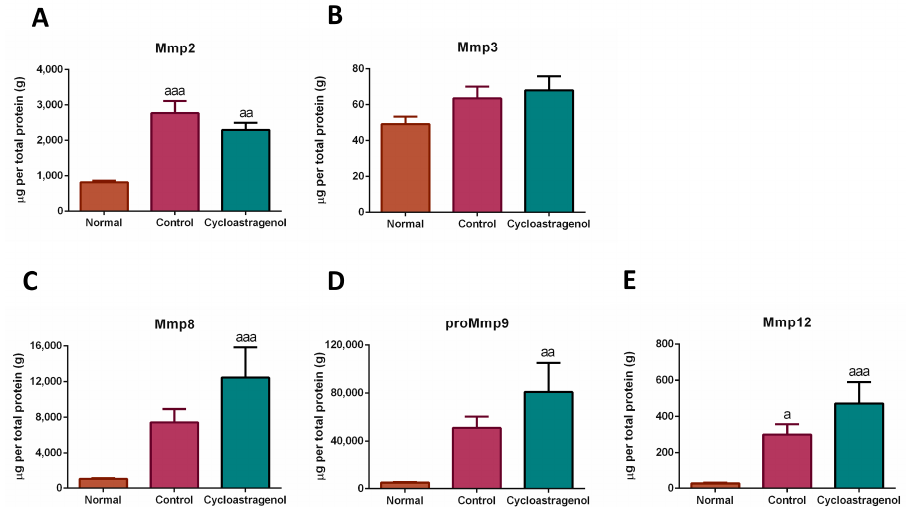
Figure 3. Effects of cycloastragenol (200 mg/kg) on the level of matrix-metalloproteinases (Mmps) in the liver of mice treated with carbon-tetrachloride. Data are expressed as the levels of Mmp2 ( A ), Mmp3 ( B ), Mmp8 ( C ), proMmp9 ( D ), and Mmp12 ( E ), per total protein content of the liver (g). Bar graphs and corresponding error bars indicate means and SEM among the same treatment, respectively ( n = 8–10). a , aa , and aaa indicate p < 0.05, 0.01, and 0.001 when compared with the normal, respectively.